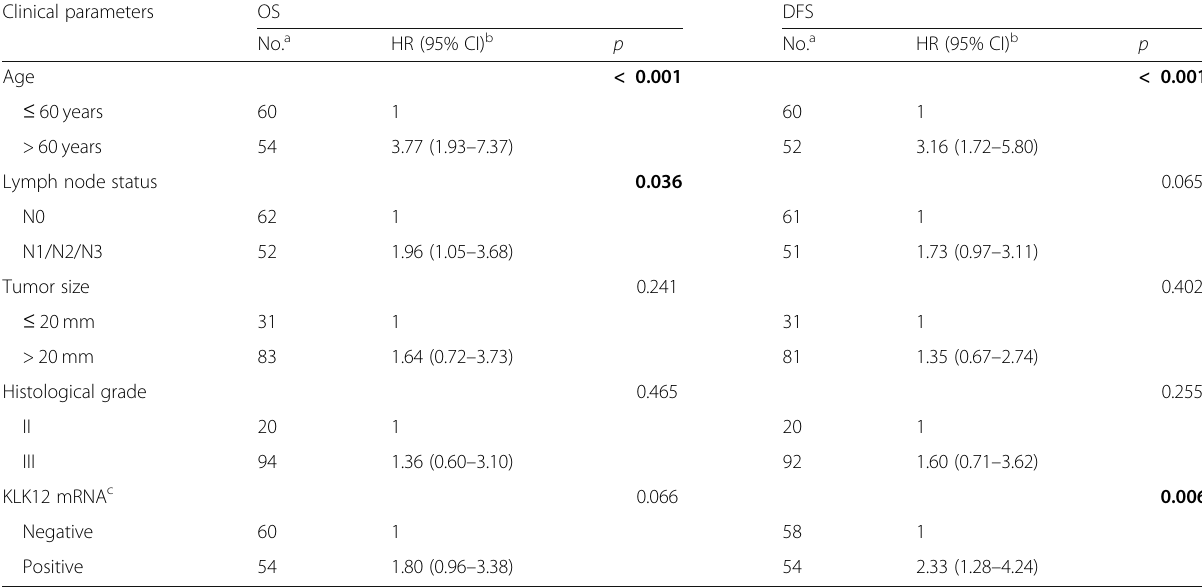
Table 3 Multivariable Cox regression analysis of KLK12 mRNA expression in relation to patients ’ outcome in triple-negative breast cancer Clinical parameters